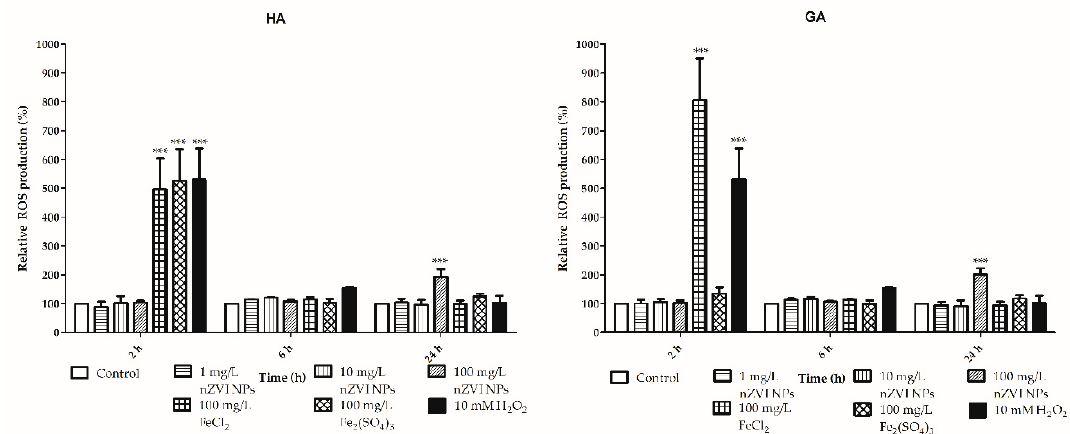
Figure 6. Reactive oxygen species (ROS) generation in granular (GA) and hyaline (HA) amoebocytes after exposure to nZVI NPs, FeCl 2 and Fe 2 (SO 4 ) 3 ; 10 mM H 2 O 2 was used as a positive control; * p < 0.05, ** p < 0.01, *** p < 0.001.